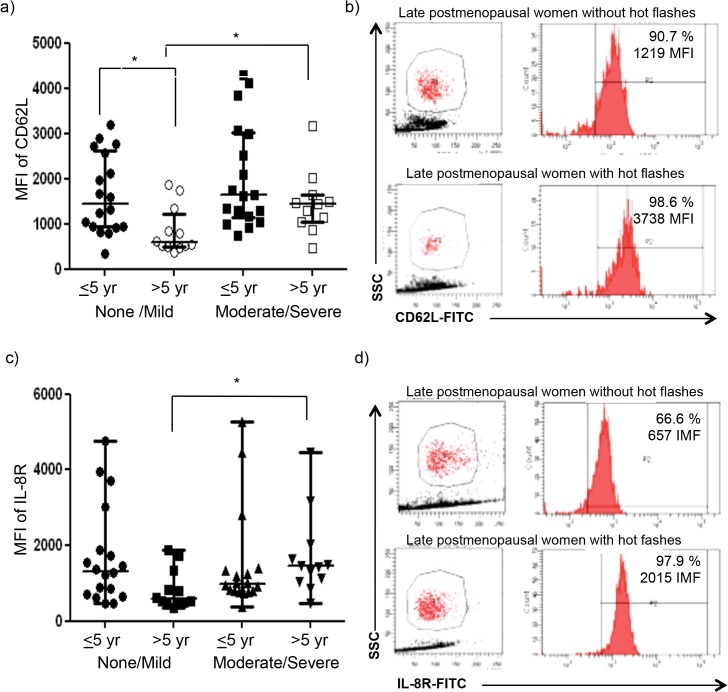
CD62L and IL-8R expression is increased on neutrophils from postmenopausal women with hot flashes.
a-b) Neutrophils were isolated as stated in Material and Methods, then labeled for CD62L or c-d) IL-8R, and the percent of cells and MFI values were determined by flow cytometry analysis. Data are shown as the median and interquartile range. *p<0.05, Kruskal-Wallis test and post hoc comparisons were carried out by Dunn´s test. Representative dot plots and histograms are shown. Red histograms correspond to CD62L (b) or IL-8R (d) staining. Percentages of positive cells and MFI values are indicated. MFI (mean fluorescence intensity).